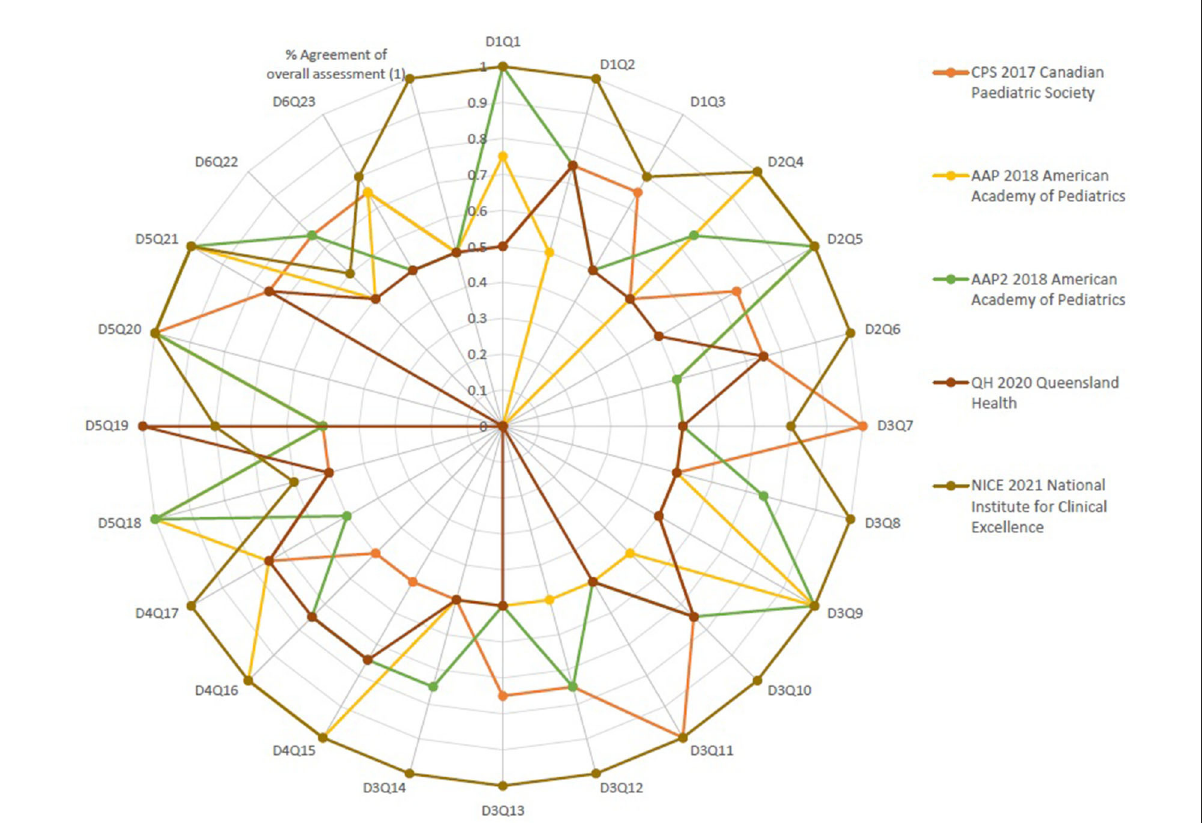
FIGURE2 Percent agreement among raters for the five source neonatal sepsis practice guidelines focusing on every question in every domain of the AGREE II